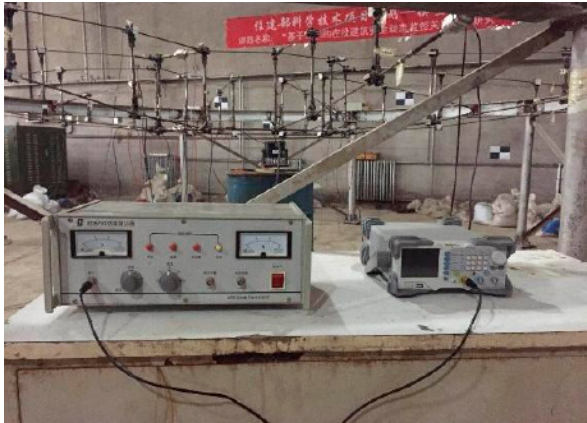
Figure 7. Data acquisition of the rate of change of cross-sectional area.